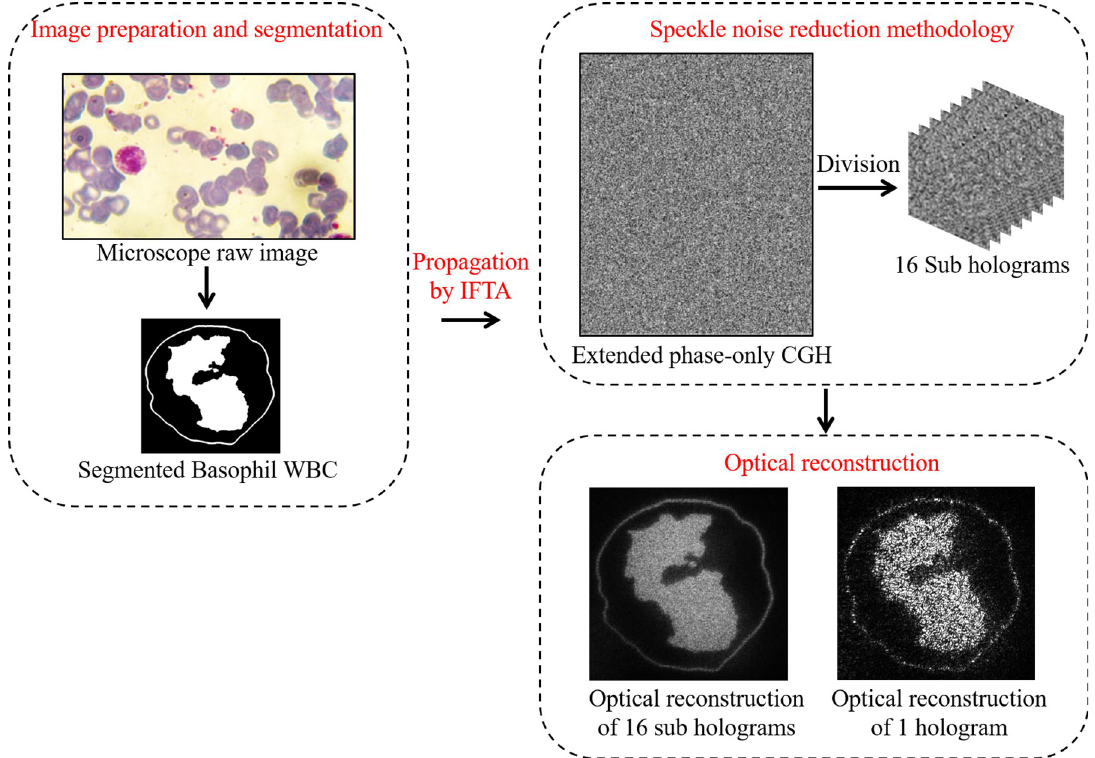
Fig 8. Flowchart summarizes the proposed work starting from the raw microscope image to the final optical reconstruction.